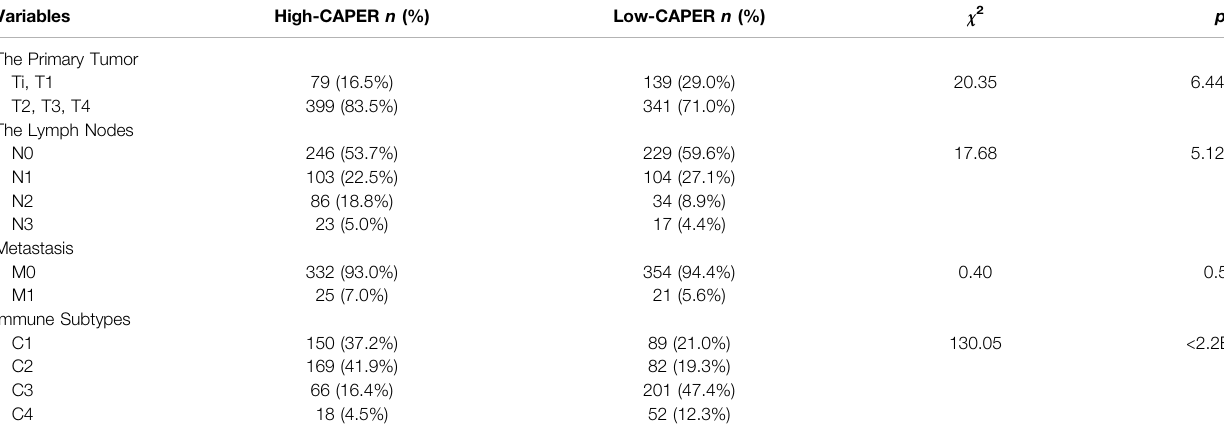
TABLE 5 | Summary of the association between clinical categorical variables and the CAPER score in TCGA. Variables High-CAPER n (%) Low-CAPER n